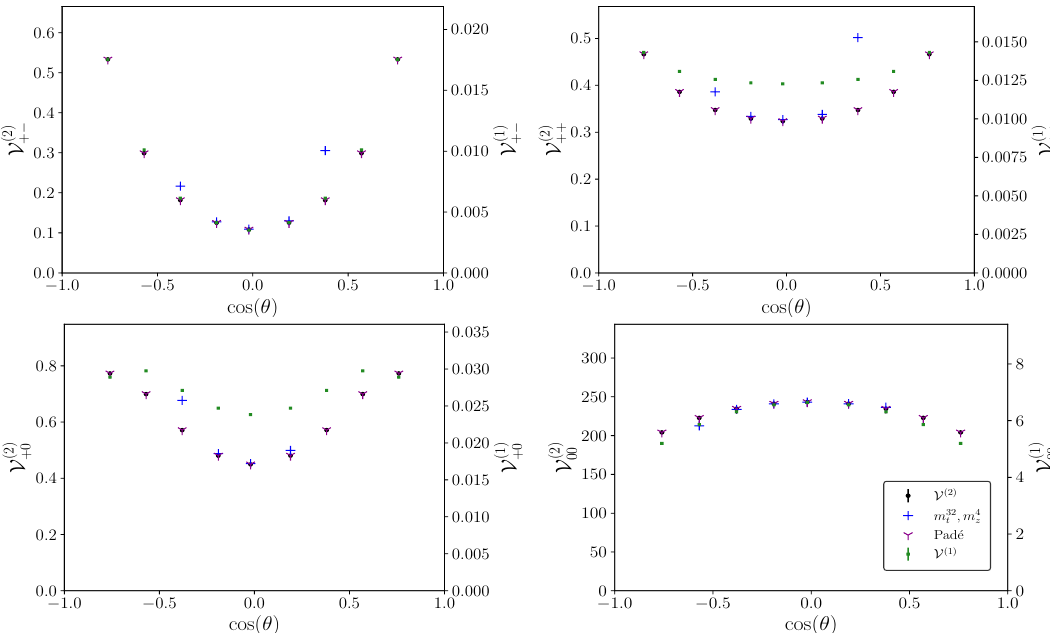
Figure 12. The cos( θ ) dependence of 1-loop and 2-loop interferences for polarised ZZ production √ in gluon fusion at s/m t = 4 . 703 . The small top-quark mass expansion (to order m 32 improved expansion [36] are shown for